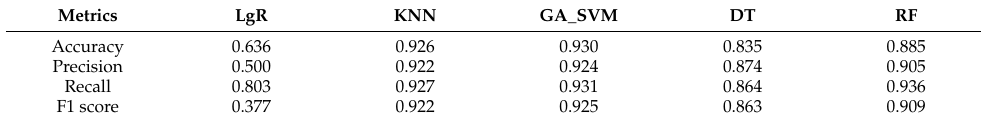
Table 4. The performance measures of all algorithms using data augmentation.